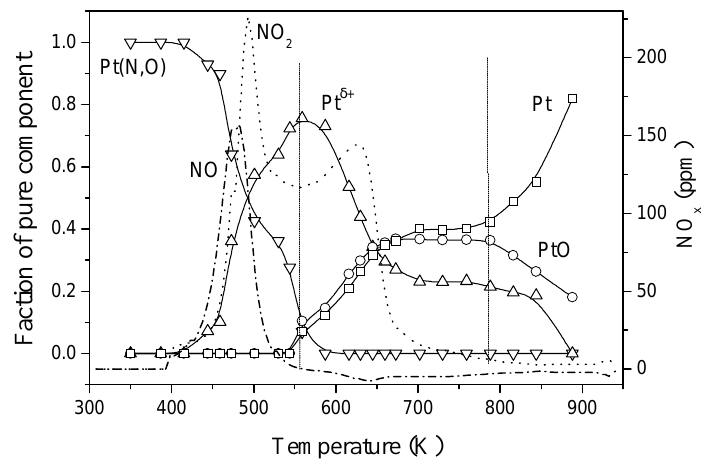
Fig. 8 Pt concentration and NO ing a temperature ramp under a stoichiometric C